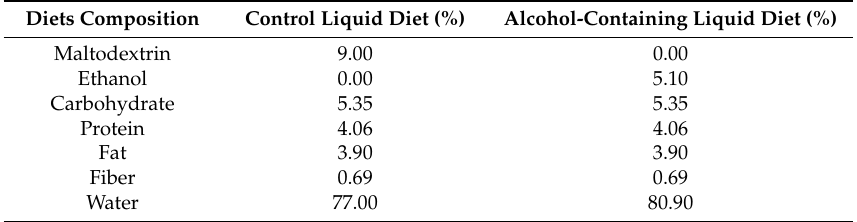
Table 1. The compositions of control vs. alcohol liquid diet (one-kilogram liquid diet). Diets